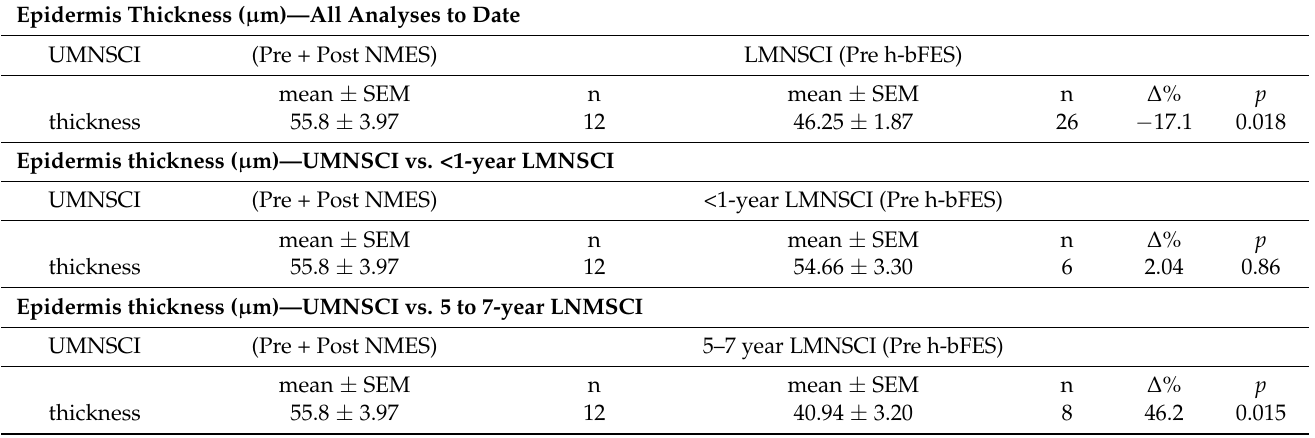
Table 4. Epidermis thickness ( µ m) in UMNSCI vs. LMNSCI.